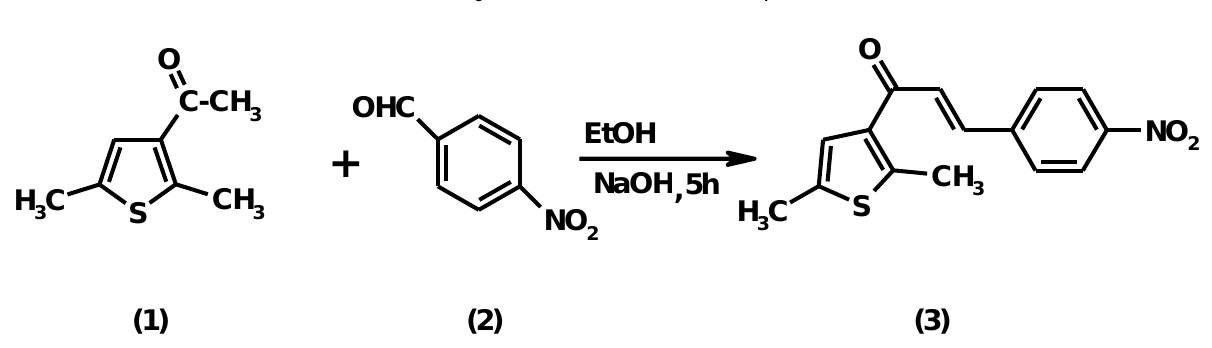
Scheme 1. Synthesis of the title compound ( 3